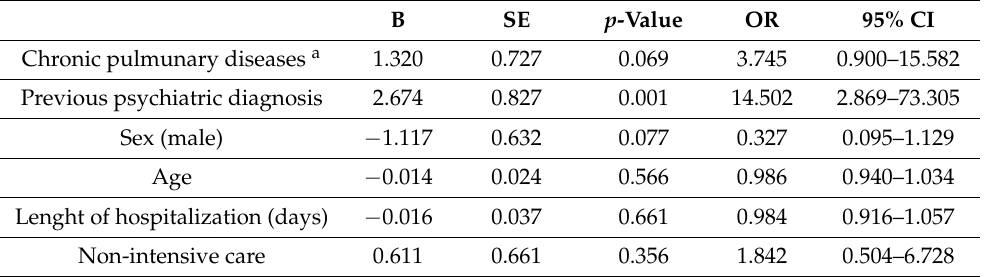
Table 3. Binary logistic regression model predicting PHQ-9 based diagnosis of